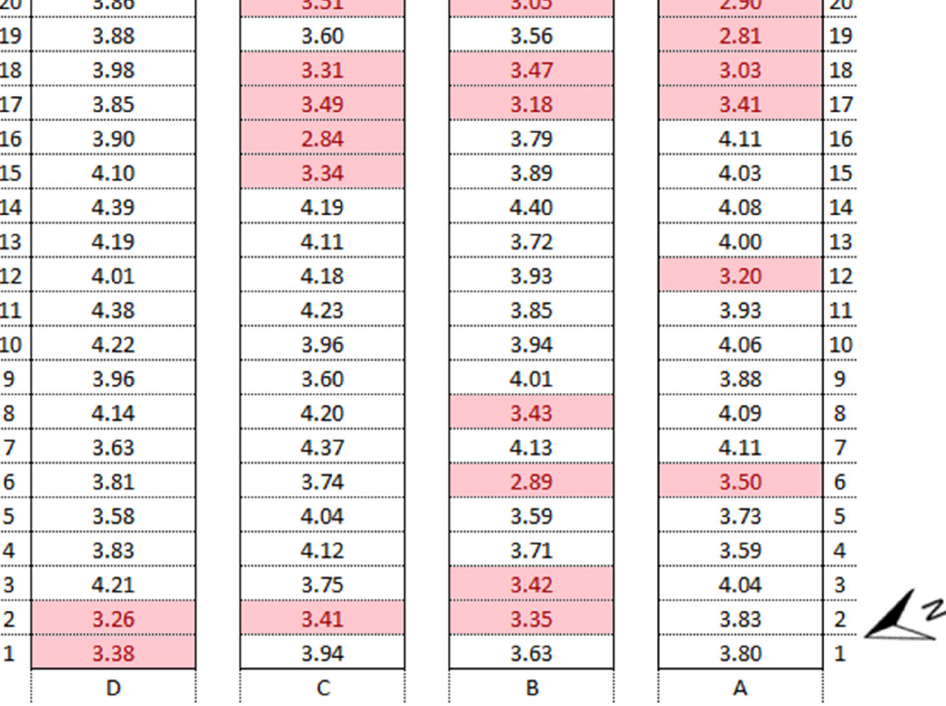
Table 6. Comparison of the mean values of VI and yields for the experiment (WHOLE AREA) and GREEN AREA and RED AREA plots.